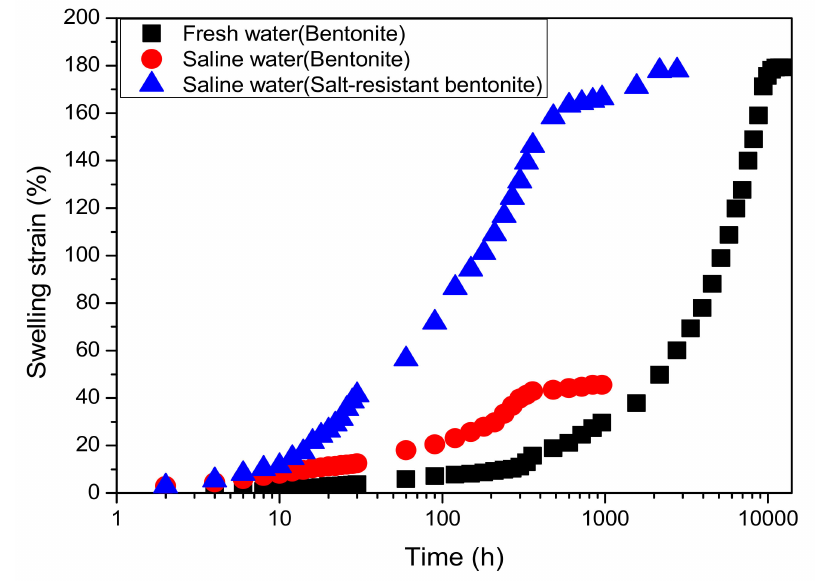
Figure 5. Relationships between the unloading swelling strain and swelling time for NB (Natural sodium bentonite) and MB (Modified